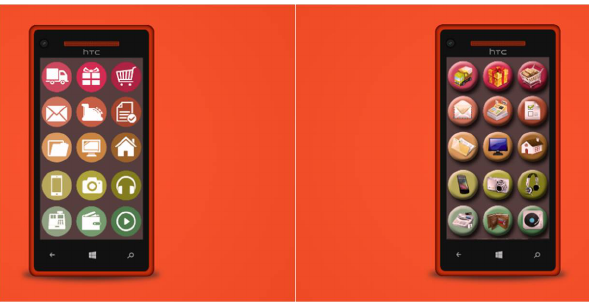
Figure 1. Screens displayed to users in Step 1 (click on the icon with the headphones).